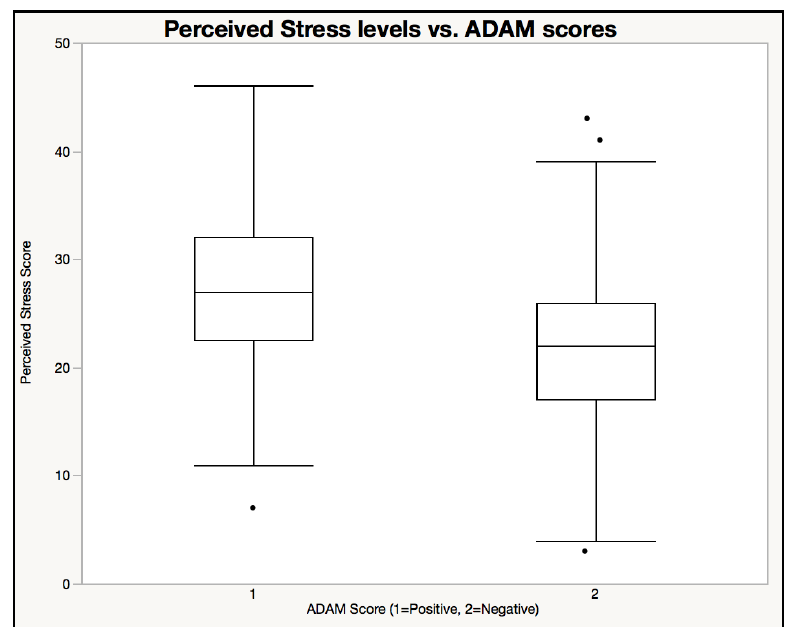
Figure 2. Perceived Stress levels vs. ADAM scores. Participants with positive ADAM scores self-reported higher levels of stress (PSS Mean = 26.82 ± 6.91) than participants with negative ADAM scores (PSS Mean = 21.26 ± 6.91).